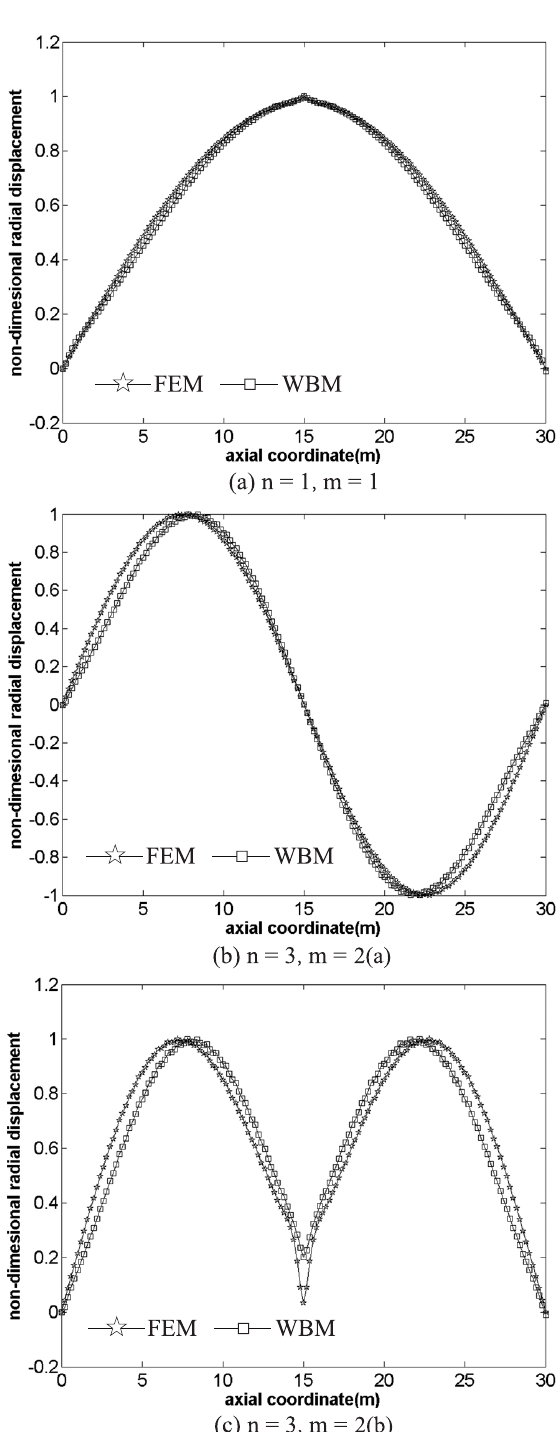
Fig. 8. Comparison of vibration mode shapes of model M1 calculated by FEM and WBM for SD-SD boundary